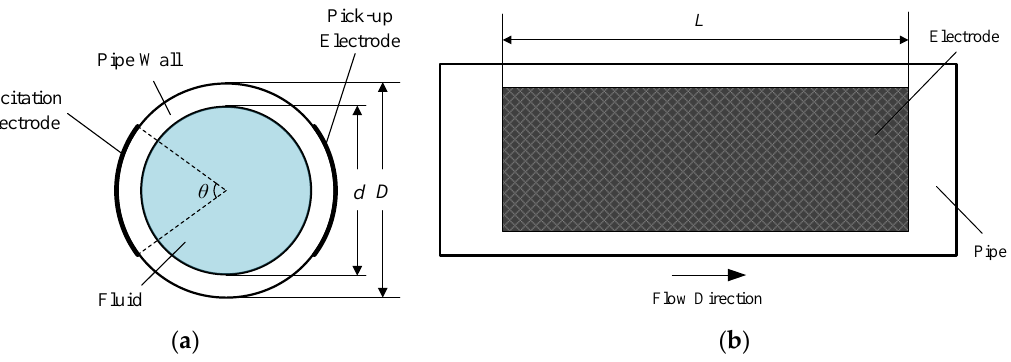
Figure 3. Views of the radial configuration: ( a ) The sectional view; ( b ) The lateral